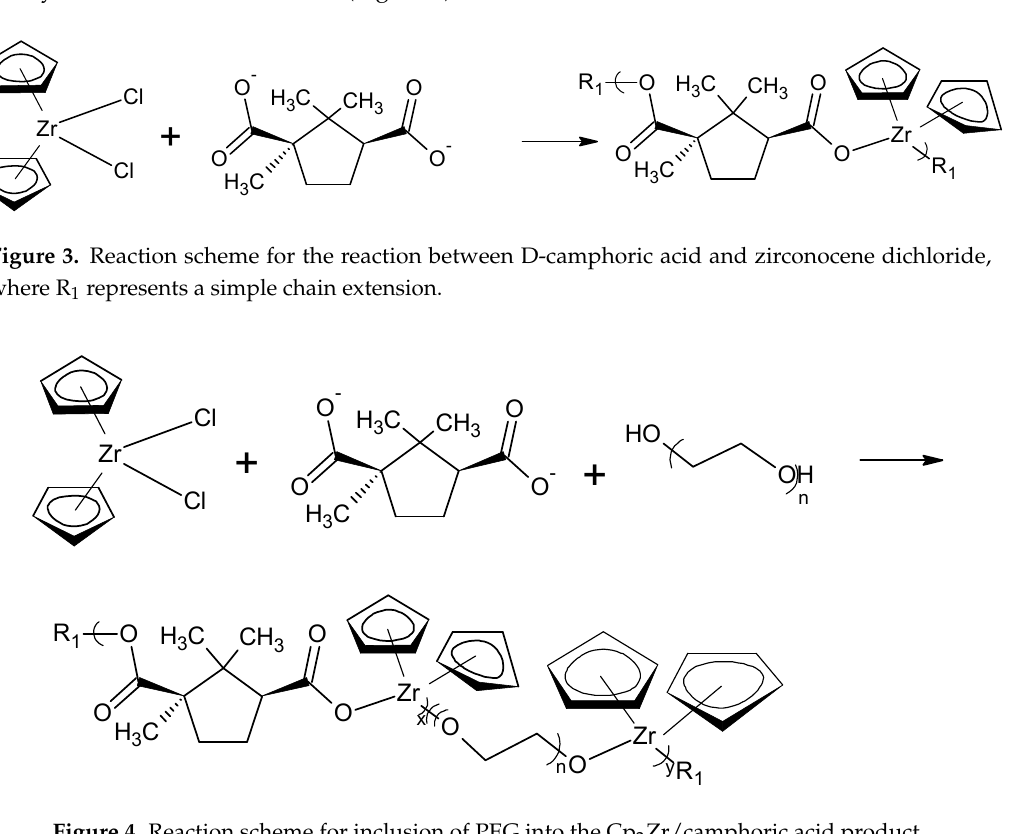
Figure 4. Reaction scheme for inclusion of PEG into the Cp 2 Zr/camphoric acid product.